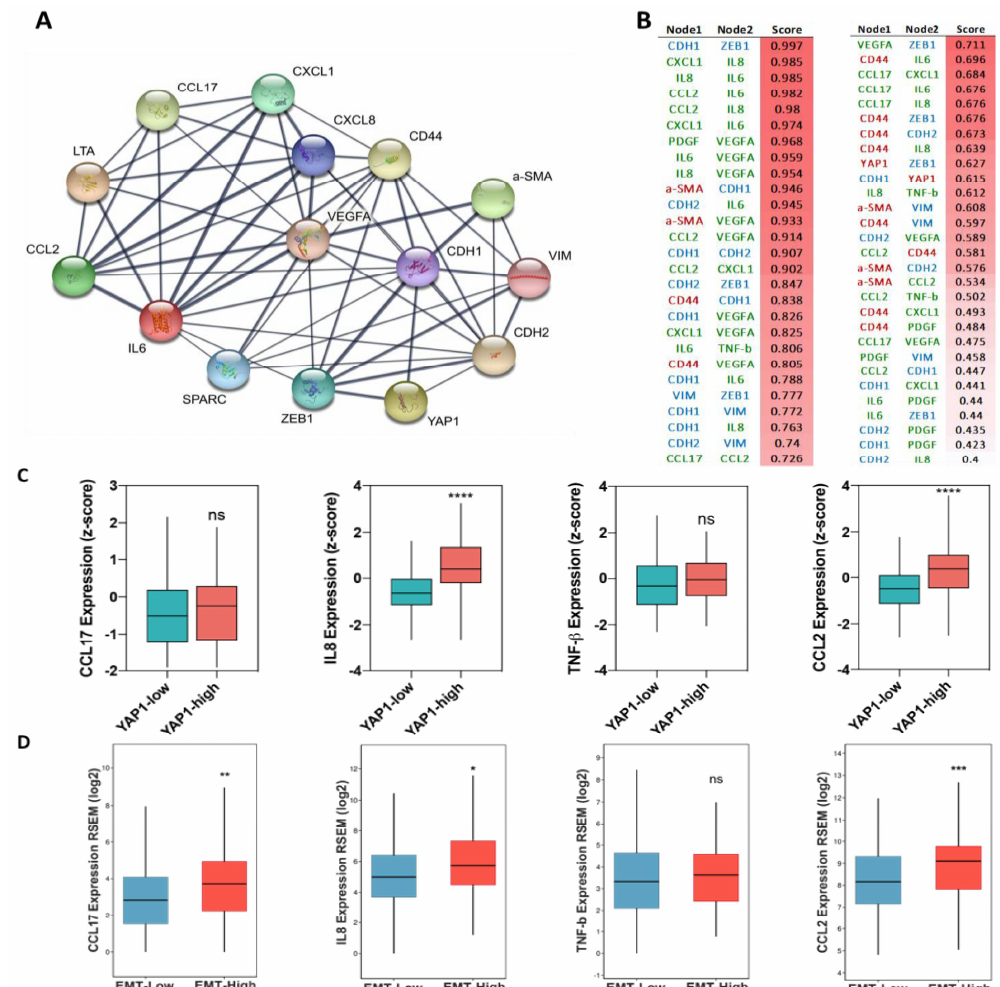
Figure 6. The association between targeted cytokines with EMT and YAP1. ( A ) The graphical image of the network between related genes, showing an association between EMT, stemness, and YAP1. ( B ) Scoring results between nodes in the PPI network. ( C ) Comparison between the expression of four identified cytokines in samples with high- and low expression of YAP1 in breast cancer indicating enrichment of these cytokines in YAP1-high samples. ( D ) Key cytokines are enriched in samples with high EMT score. * p < 0.05, ** p < 0.002, *** p < 0.0002, **** p < 0.0001, using the Student t